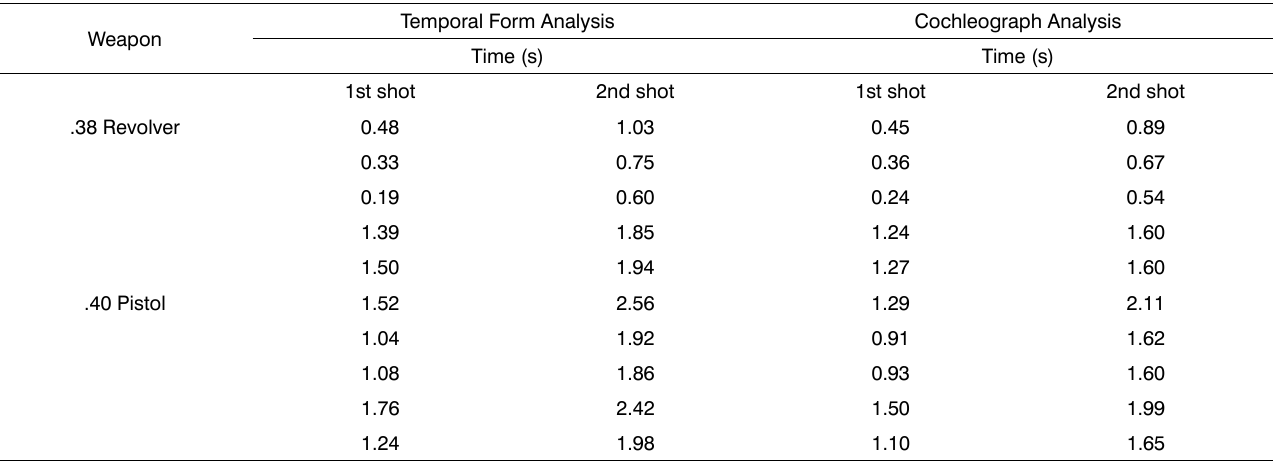
Table 1. Time values in seconds, corresponding to the sound intensity level curve peaks (dB) and the curves of greater cochle- ograph excitation for the two sequences of shots from 10 samples of weapons. Temporal Form Analysis Cochleograph Analysis Weapon Time (s) Time (s) 1st shot 2nd shot 1st shot 2nd shot .38 Revolver